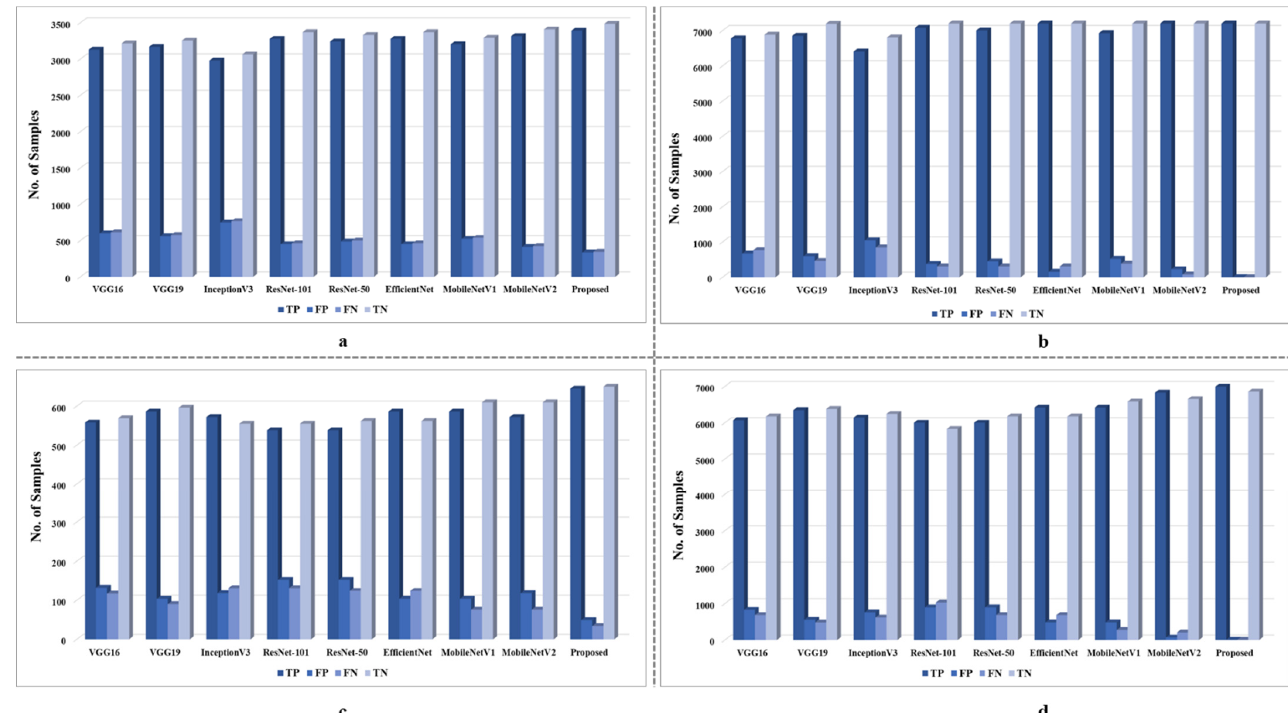
Figure 3. The detailed performance of each model in terms of TP, TN, FP, and FN where ( a )—FMD original dataset, ( b )—FMD augmented dataset, ( c ) FM—original dataset, and ( d )—FM augmented dataset.